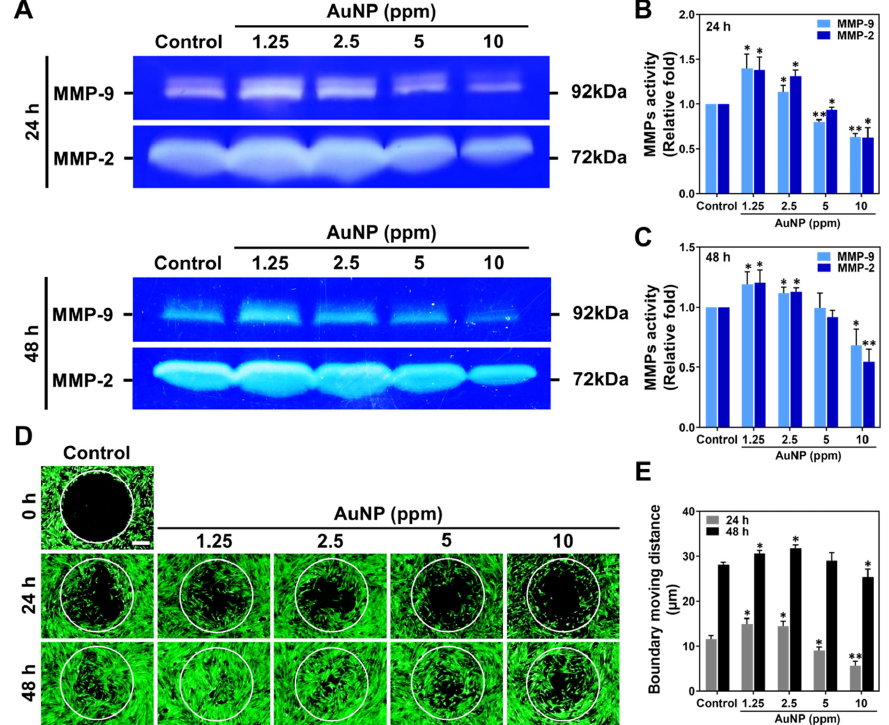
Figure 5. Metalloproteinase activities and cell migration ability of MSCs stimulated by AuNPs. ( A ) The zymography of MMP-2/9 enzymatic activities at 24 and 48 h are shown. ( B , C ) The expression level of MMP-2/9 at 24 and 48 h was semi-quantified. Both MMP-2 and MMP-9 protein expression were significantly increased in 1.25 and 2.5 ppm AuNP treatments. ( D ) The fluorescence images of the MSCs’ migration ability are displayed. Scale bar = 200 µ m. ( E ) The boundary moving distance was measured, and the result explains that the 1.25 and 2.5 ppm AuNP groups remarkably strengthened the moving distance of MSCs. The images were exhibited from one of three independent experiments. The semi-quantitative data are shown as mean ± SD ( n = 3). * p < 0.05, ** p < 0.01: compared to the Control group